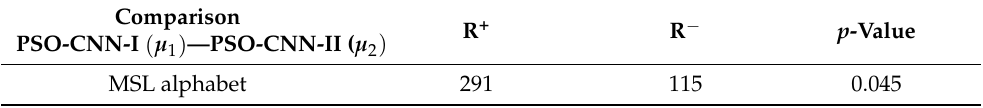
Table 19. Z-test results for the ASL